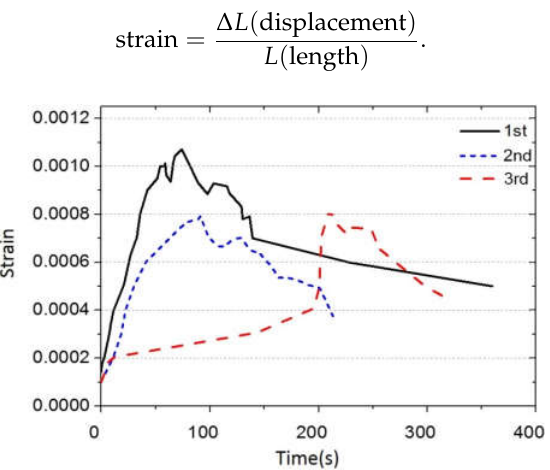
Figure 2. Strain measured for soldering the terminals to the direct bonded copper (DBC).